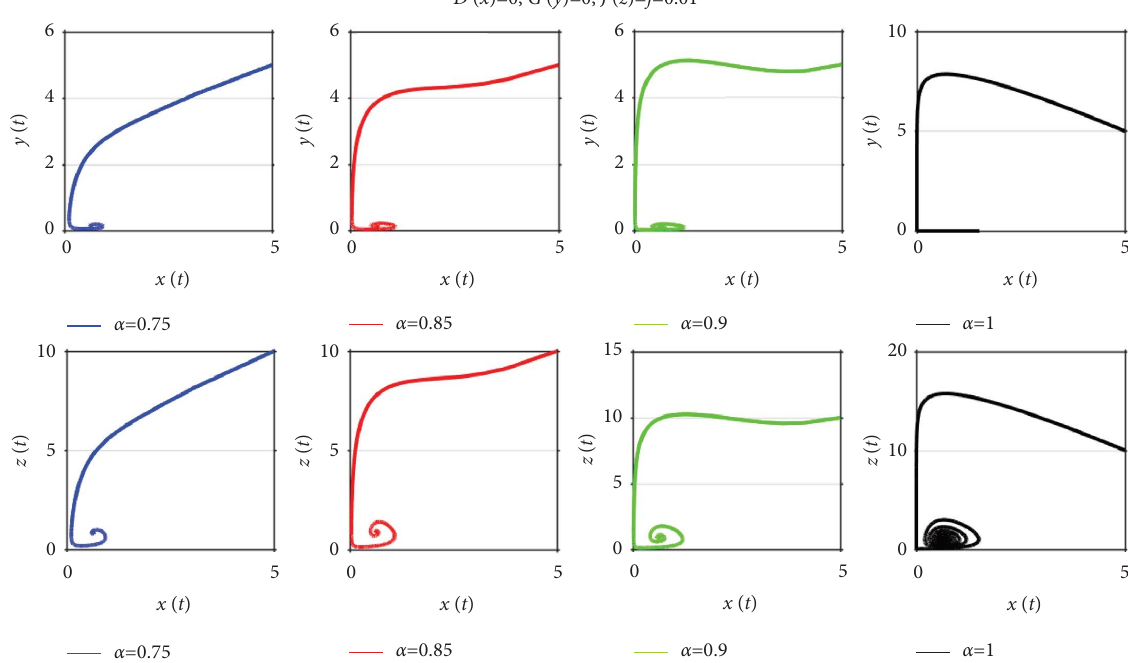
Figure 7: Phase space for the one prey-two predators system, where D ( x ) � 0 , G ( y ) � 0 , J ( z ) � j � 0 . 01 , a � b � c � 0 . 1 , e � h � 0 . 3 , f � i � 0 . 2 , and α � 0 . 75 , 0 . 85 , 0 . 9 , 1